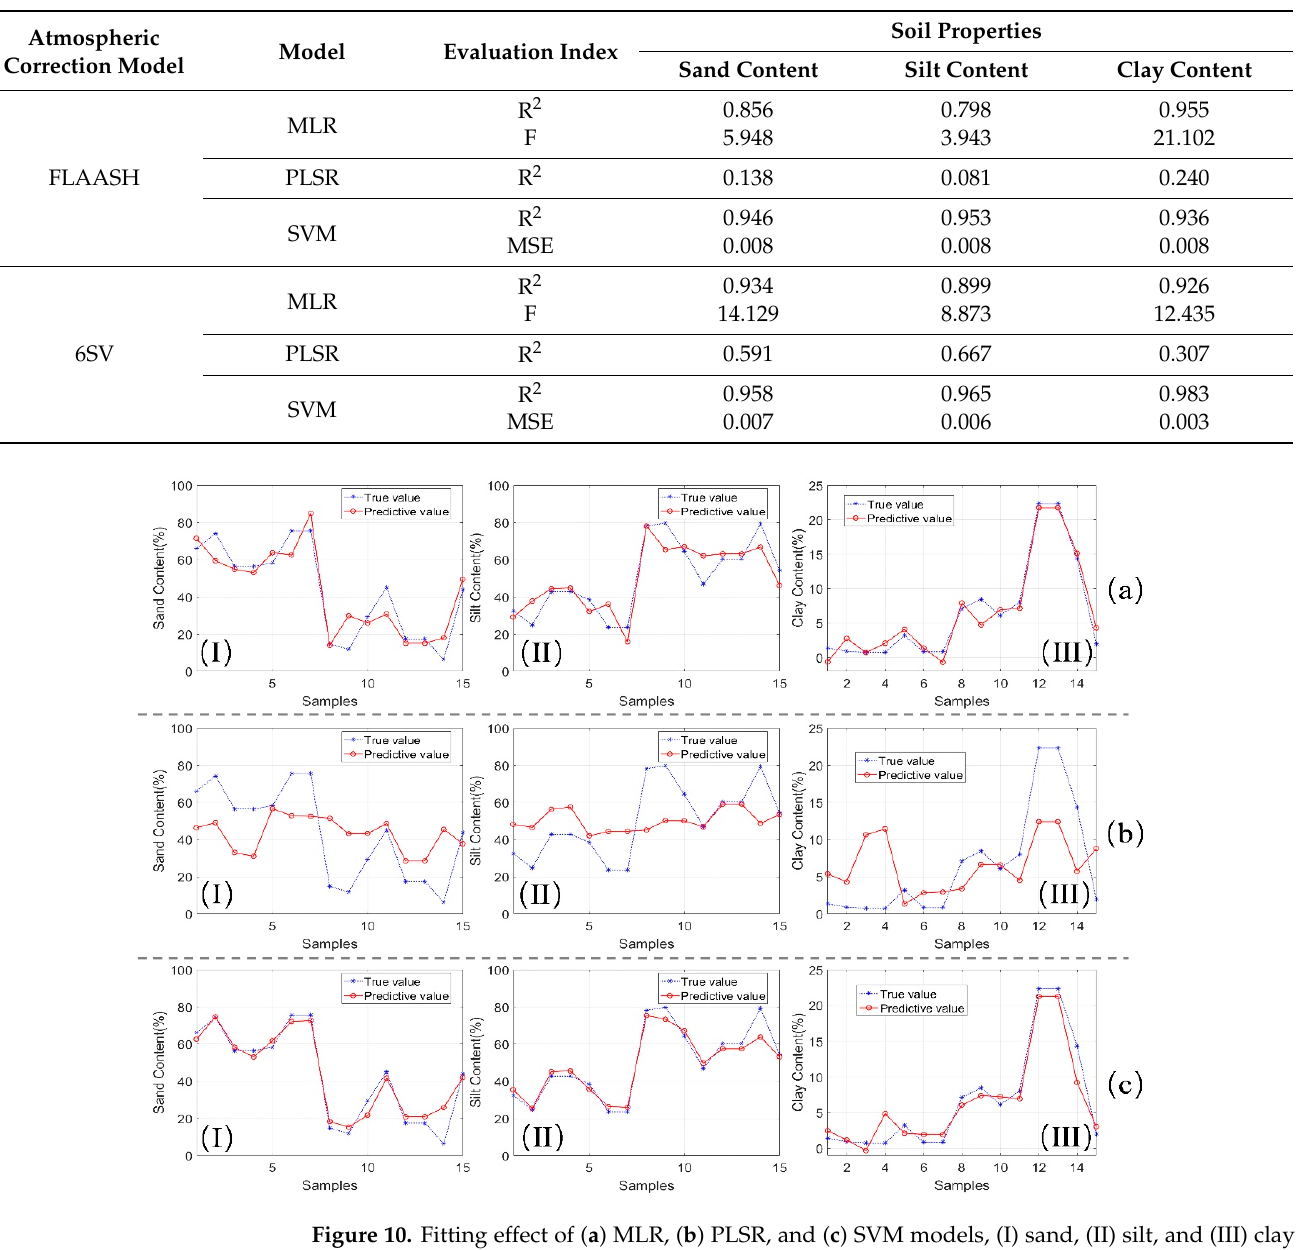
Figure 11. Regression between predicted and true values of ( a ) MLR, ( b ) PLSR, and ( c ) SVM models, (I) sand, (II) silt, and (III) clay content using FLAASH atmospheric correction surface reflectance data.